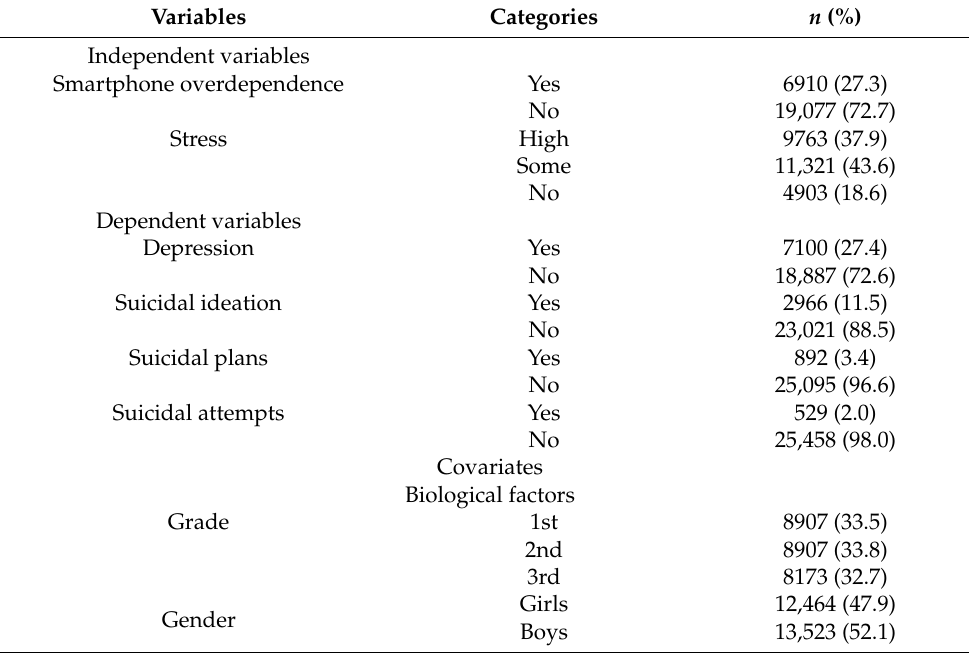
Table 1. Characteristics of smartphone overdependence, stress, depression, suicide-related behaviors, and